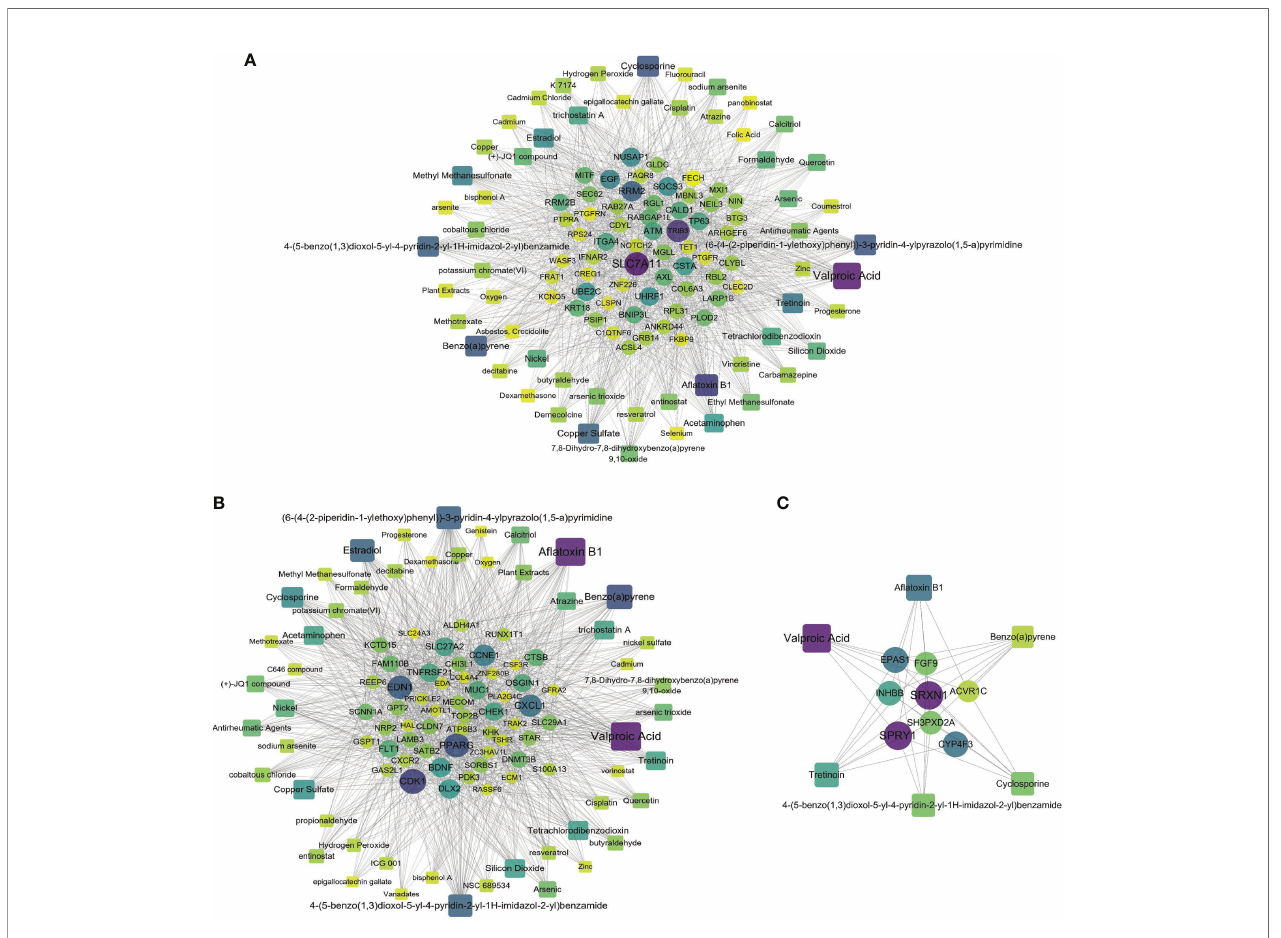
FIGURE 7 | Relationship of COVID-19 and psychiatric disorders with regard to chemical and protein agents. Panels (A – C) illustrate the chemical – protein networks of COVID-19 with BD, SZ, and LOD, respectively. Circles designate proteins and squares designate chemical compounds. Overexpressed proteins and chemicals are designated by larger size and darker color. Squares having multiple edges are the most overexpressed chemical